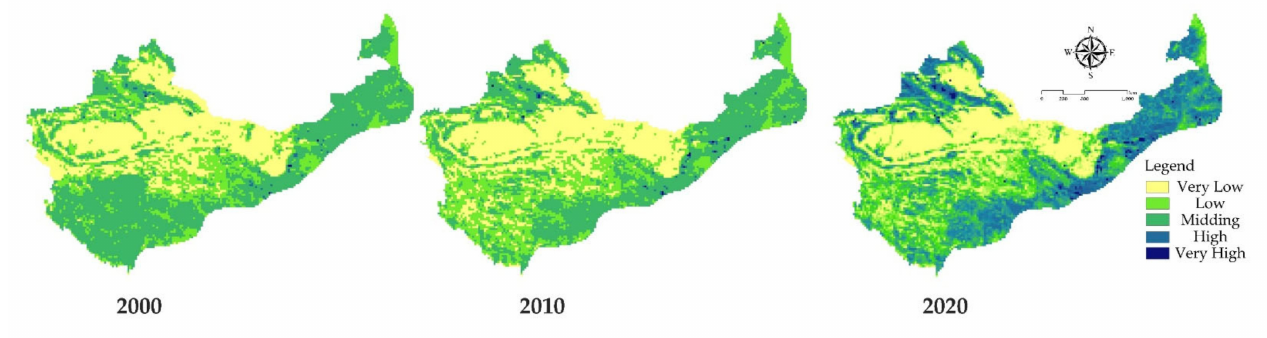
Figure 3. Spatial distribution characteristics of the average human activity intensity on a 20 km scale in 2000, 2010, and 2020.